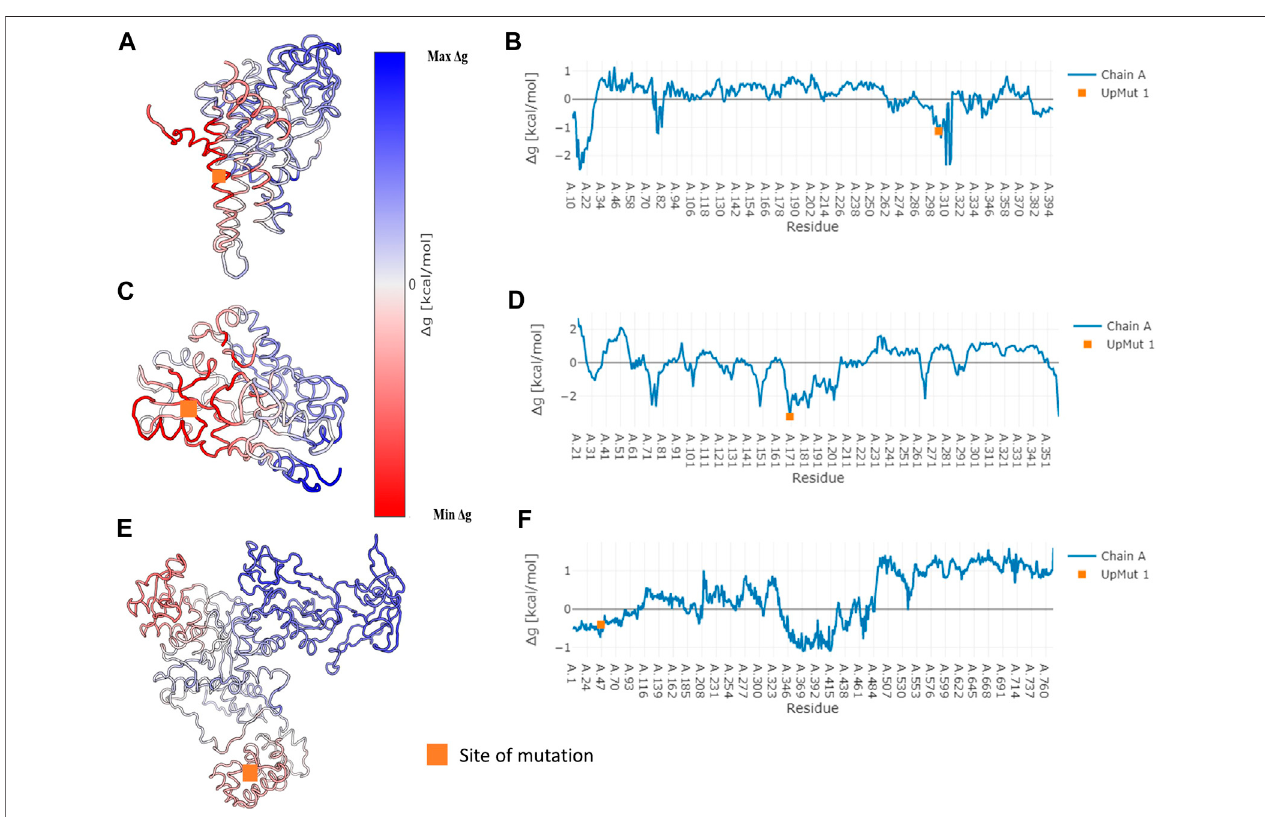
FIGURE 4 | Free energy values obtained for three speci fi c proteins that undergo disease-causing mutation. Speci fi c cases where we observe signi fi cant network variability have been subject to the analysis of allosteric effects due to mutation. The AlloSigMA server employs the SBSMMA (Guarnera and Berezovsky, 2016) method to generatethe responsefree energies when perturbations (UPmutation)are introduced at known sites ofdisease-causing mutations. Cartoon ofthe wildtypecoloured according to their free energy values obtained for the cases of (A) Medium-chain speci fi c acyl-CoA dehydrogenase, (C) Porphobilinogen deaminase and (E) Glutamine--tRNAligaseareshownontheleft.Theirfreeenergypro fi lesareillustratedgraphicallywithresidueindexonthe x -axisand Δ gvalueonthe y -axisin (B) , (D) and (F) shown on the right in the same order. The orange square points to the site of mutation.